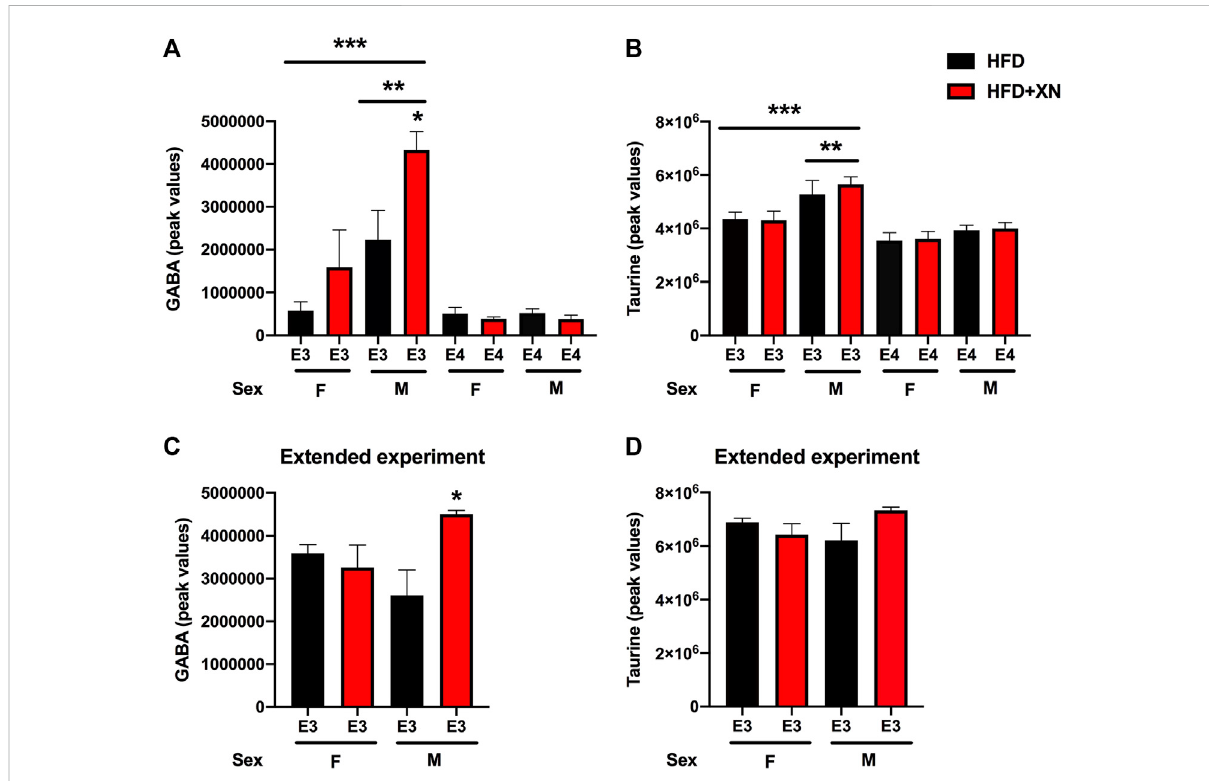
FIGURE 8 HippocampalGABAandtaurinelevels. (A) Inthestandardexposureexperiment,XNincreasedGABAlevelsinE3males.* p =0.0265.GABAlevelswere higher in E3 males than E3 females. ** p = 0.0036. GABA levels were higher in E3 than E4 mice. *** p = 0.0002. (B) In the standard exposure experiment, taurine levels were higher in E3 malesthan females. ** p = 0.0039. Taurinelevels were also higher in E3 than E4 mice. *** p < 0.0001. (C) In the extended experiment, XN also increased GABA levels in E3 males. * p = 0.0265. (D) No effect of XN on taurine levels were seen in the extended